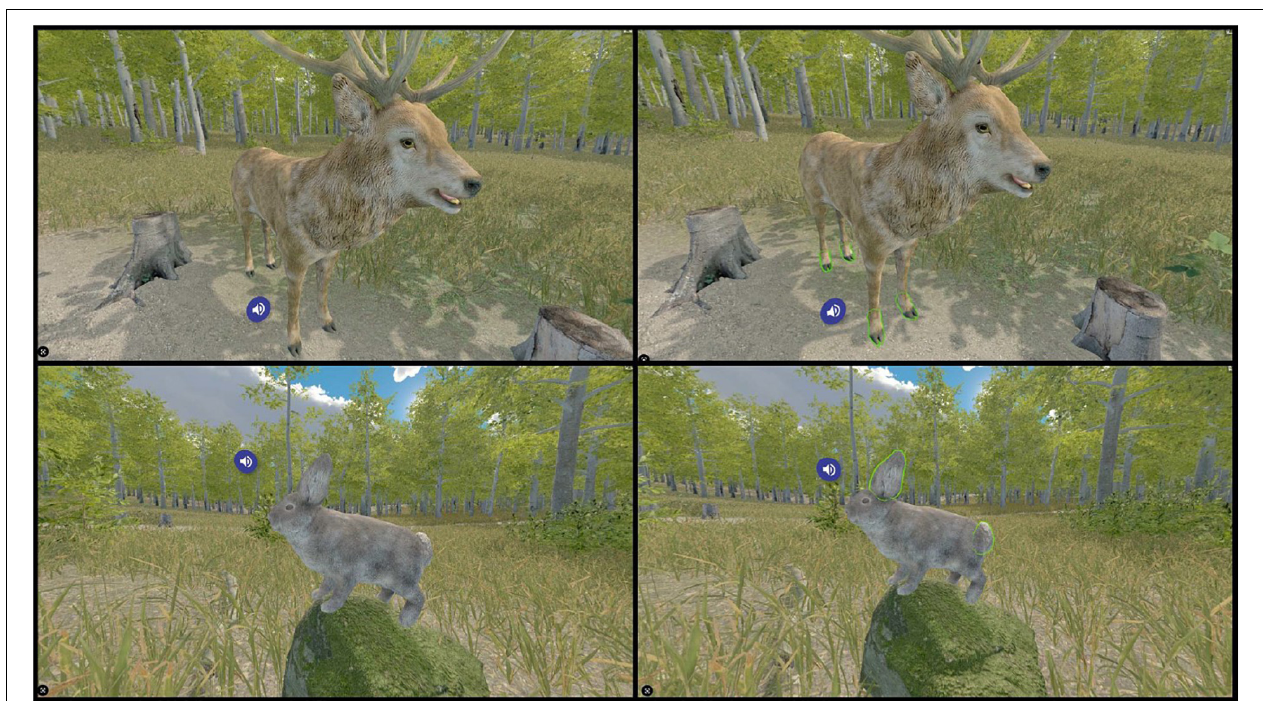
FIGURE 1 | Desktop virtual learning environment with signals and without signals in comparison. The learning environment was displayed in full screen and the participants could turn 360 ◦ in any